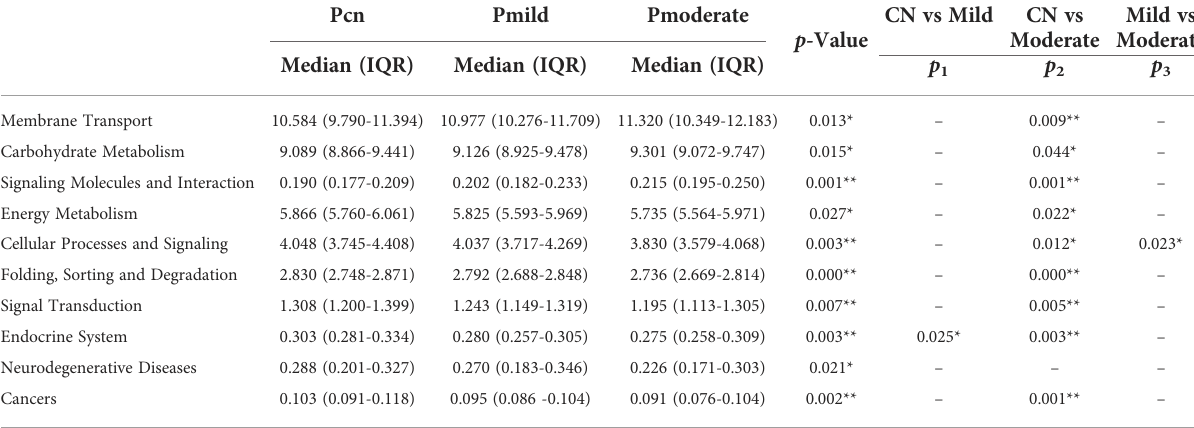
TABLE 2 PICRUSt-based examination of the oral bacterial functions among the three